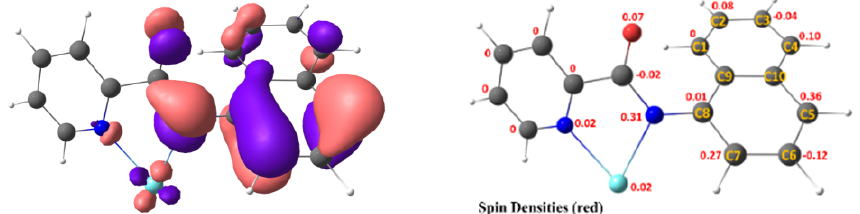
Figure 1. The intermediate B was optimized using B3LYP in combination with the LANL2TZ effective core potential (ECP) for Ag, and 6–311G (d, p) for all other atoms. The D3 version of Grimme’s dispersion (GD3) and Truhlar’s SMD solvation model with acetone as the model solvent was adopted for the geometry optimization. Spin densities (red) are in atomic units. The single occupied molecular orbital (SOMO) is depicted with 0.03 au − 3/2